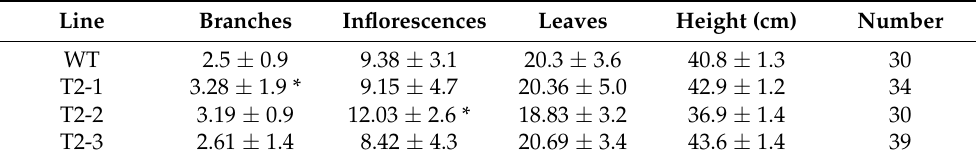
Table 1. Shoot architecture phenotypes of p35S:LhWOX5 Arabidopsis